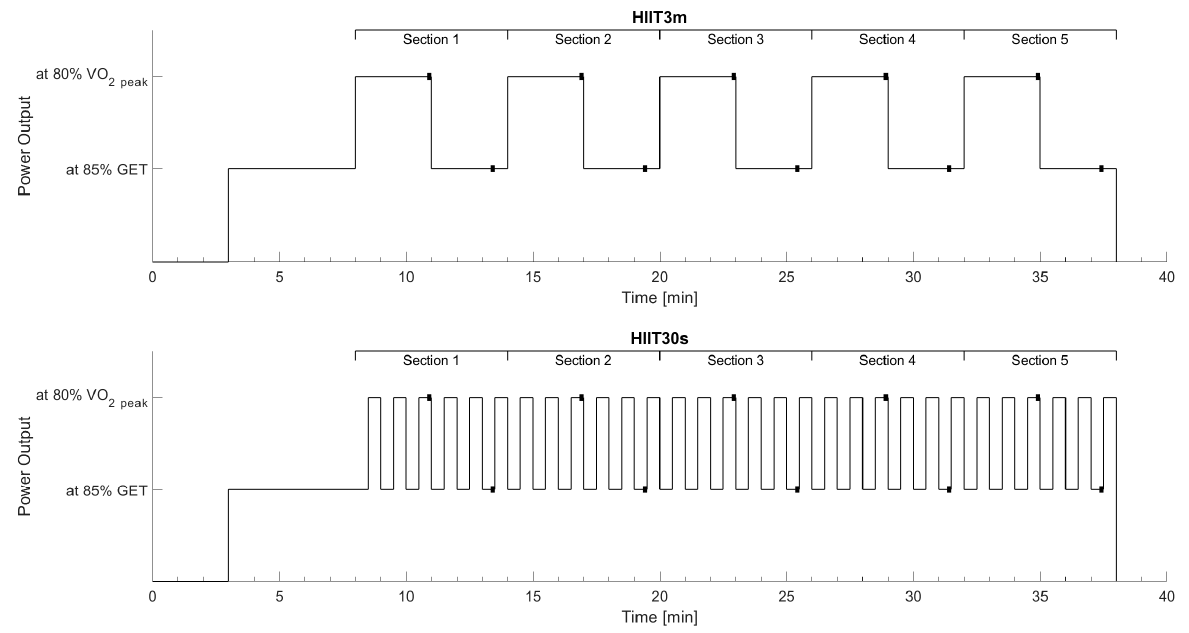
Figure 1. Scheme of HIIT3m and HIIT30s protocol regarding interval intensities and duration. The black squares demon- strate the 10 s period, where the means for work (loaded) and resting (unloaded) phases were